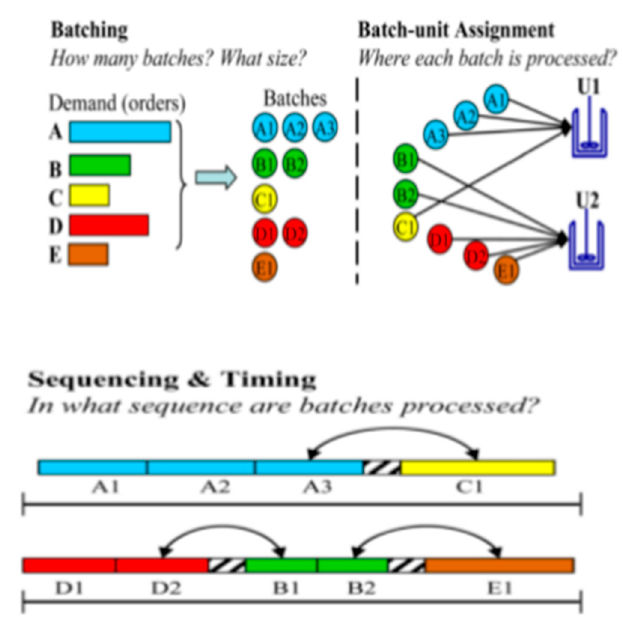
Figure 1. Major decisions in production planning decisions [8].